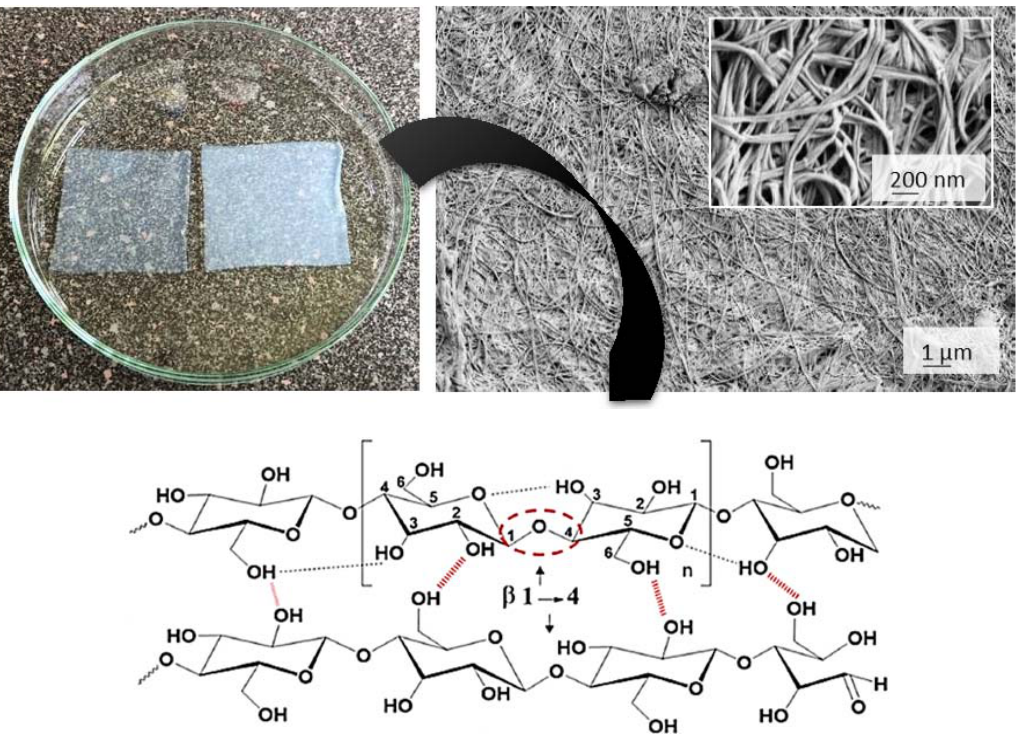
Figure 1. Macro ‐ , micro ‐ and molecular structure of bacterial cellulose (BC) membrane. Molecular Figure 1. Macro-, micro- and molecular structure of bacterial cellulose (BC) membrane. Molecular structure image adapted from [2]. structure image adapted from